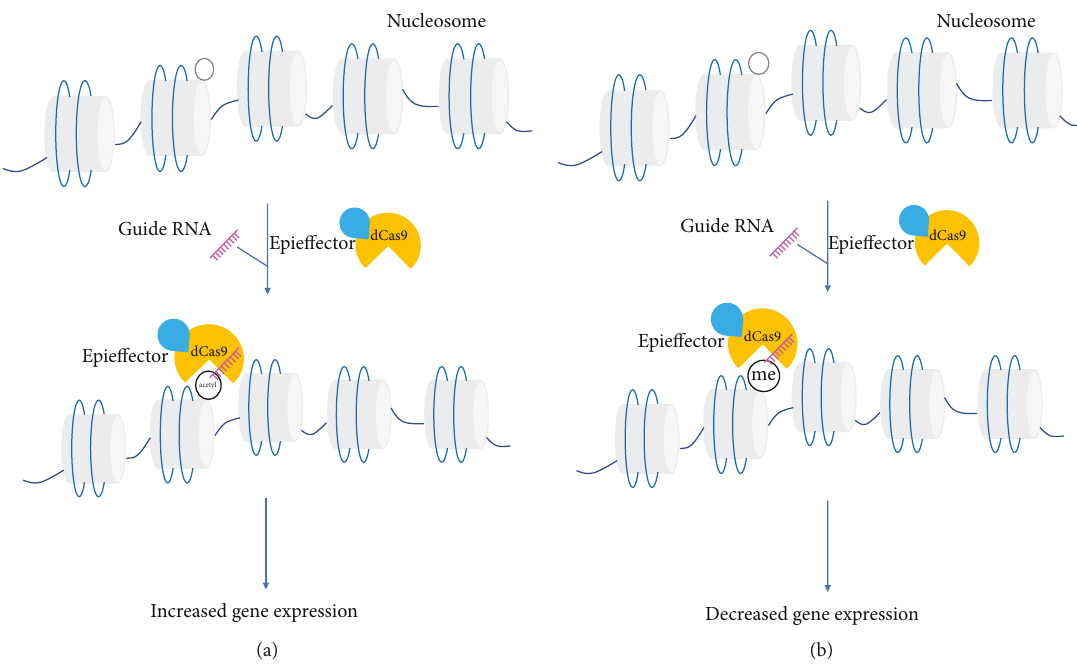
Figure 2: Histone acetylation and methylation mediated by Cas9. The empty circle attached to the nucleosome represents a speci fi c amino acid of the histone side chain. The circled “ acetyl ” and “ me ” represents acetylation and methylation of amino acids, respectively. The dCas9-epie ff ector complex could be guided to a selected DNA target to achieve (a) acetylation or (b) methylation at histone level to regulate gene expression. Table 1: Validated representative dCas9-epie ff ector